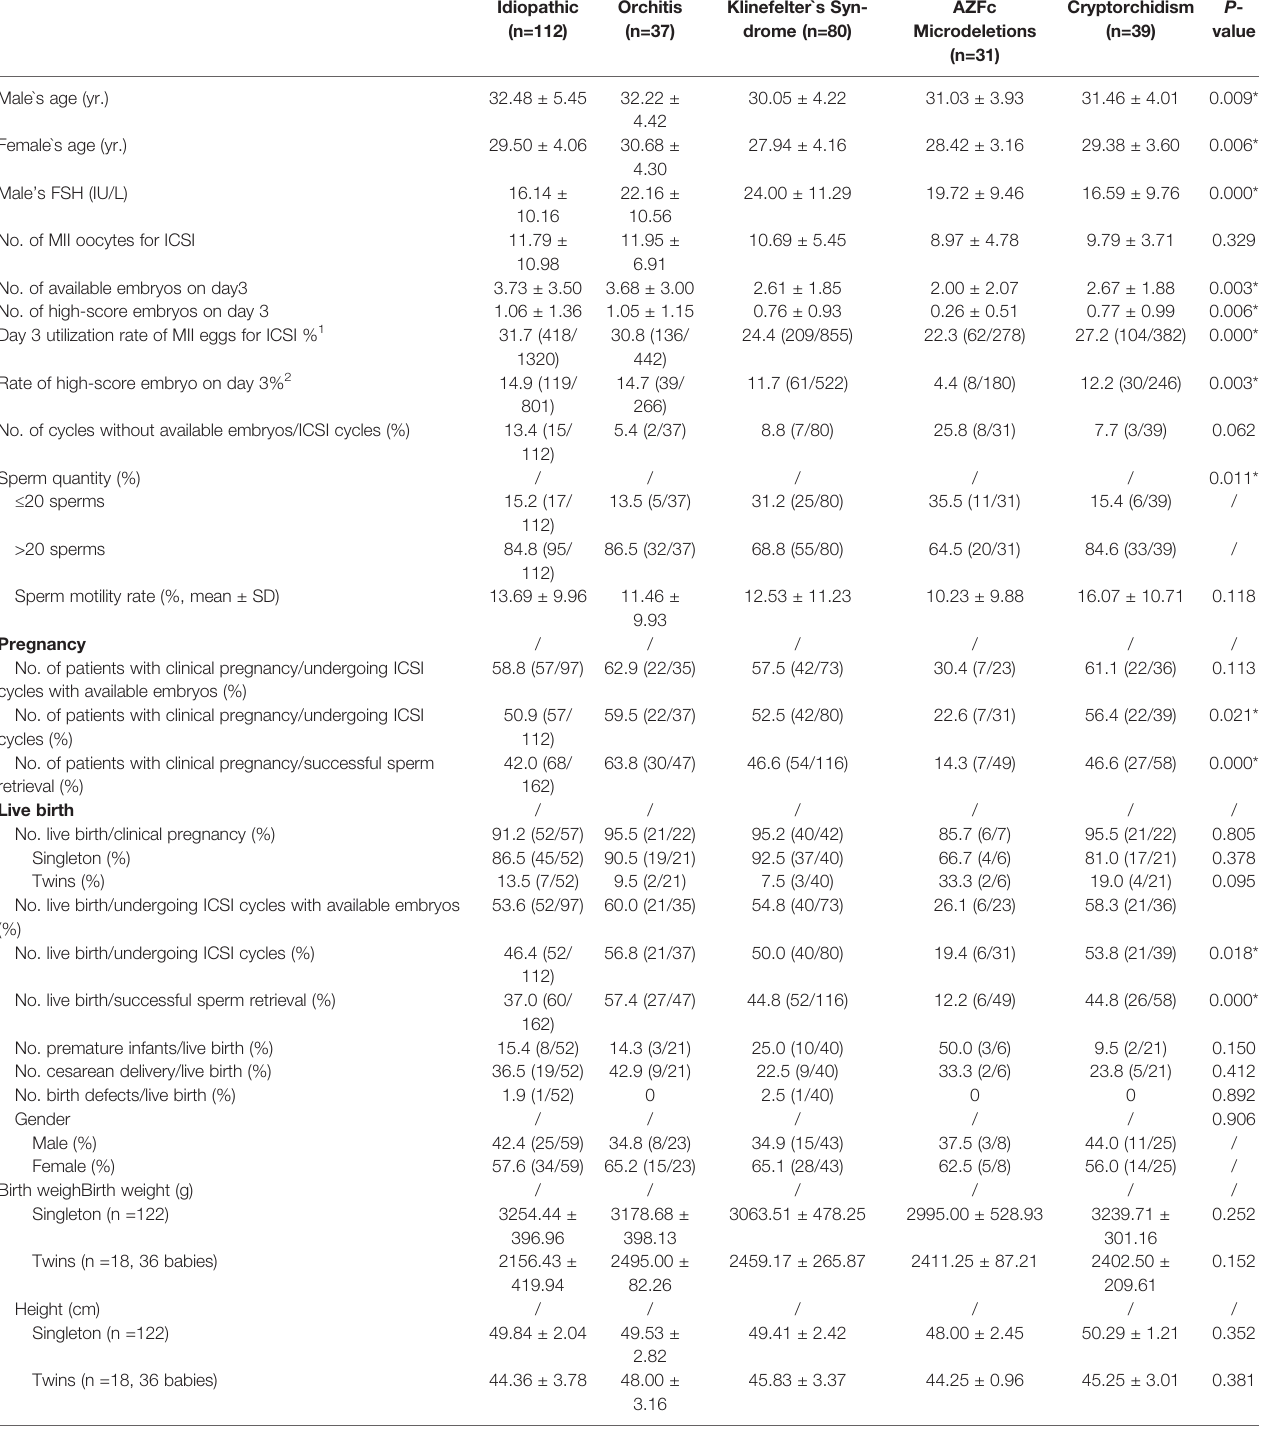
TABLE 4 | Comparison of the ICSI outcomes of NOA patients with different etiologies.